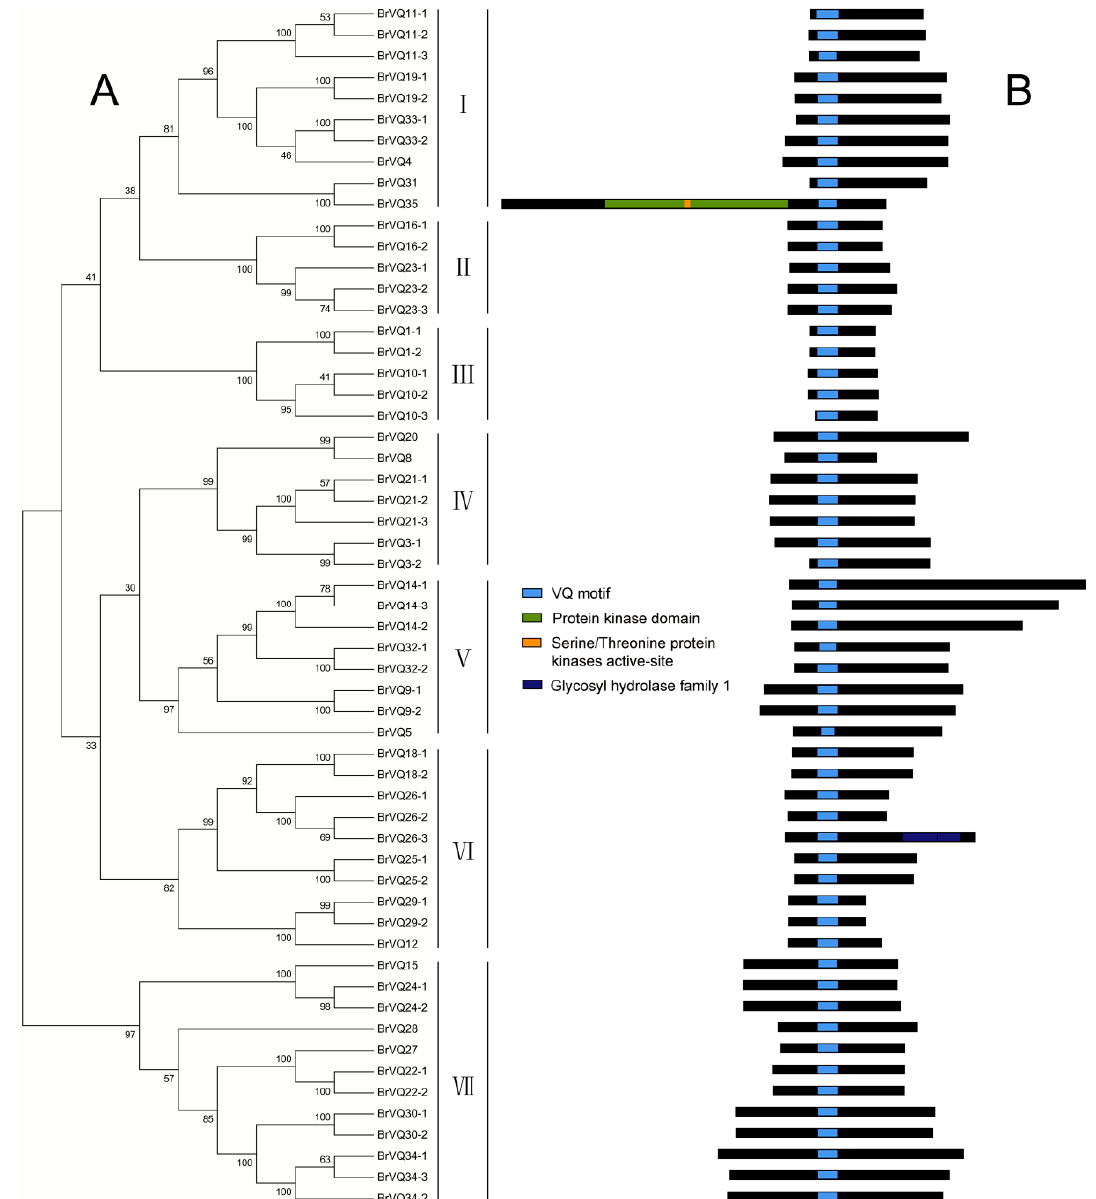
Figure 1. Phylogenetic tree and conserved domain analysis in Chinese cabbage. ( A ) The phylogenetic tree was determined in MEGA5 using the neighbor-joining method with 1000 bootstrap replicates.